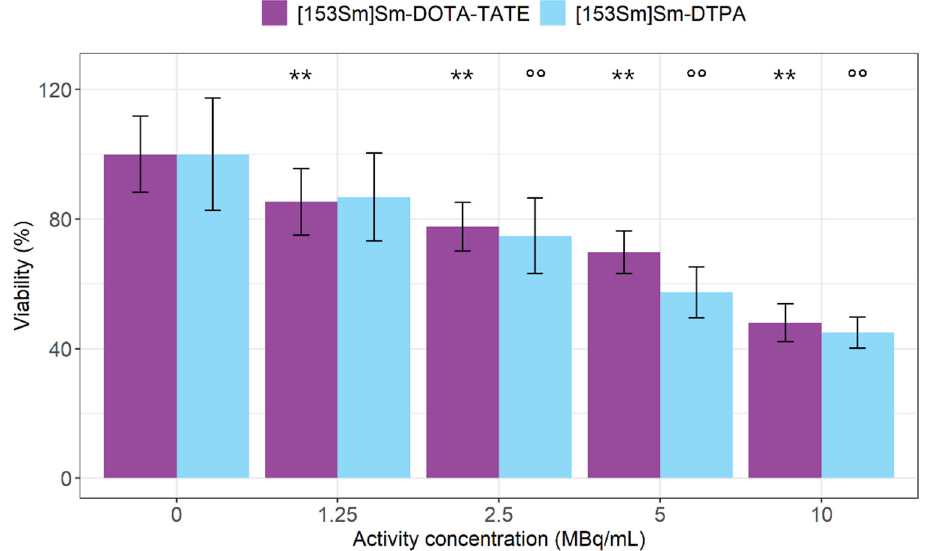
Figure 3. Percentage viability of CA20948 cells after [ 153 Sm]Sm-DOTA-TATE treatment (MBq/mL) or [ 153 Sm]Sm-DTPA treatment (MBq/mL). Values represent mean ± standard deviation. ** p < 0.01 for statistical differences relative to 0 MBq/mL [ 153 Sm]Sm-DOTA-TATE-treated cells and °° p < 0.01 for statistical differences relative to 0 MBq/mL [ 153 Sm]Sm-DTPA-treated cells, both obtained by linear modelling.